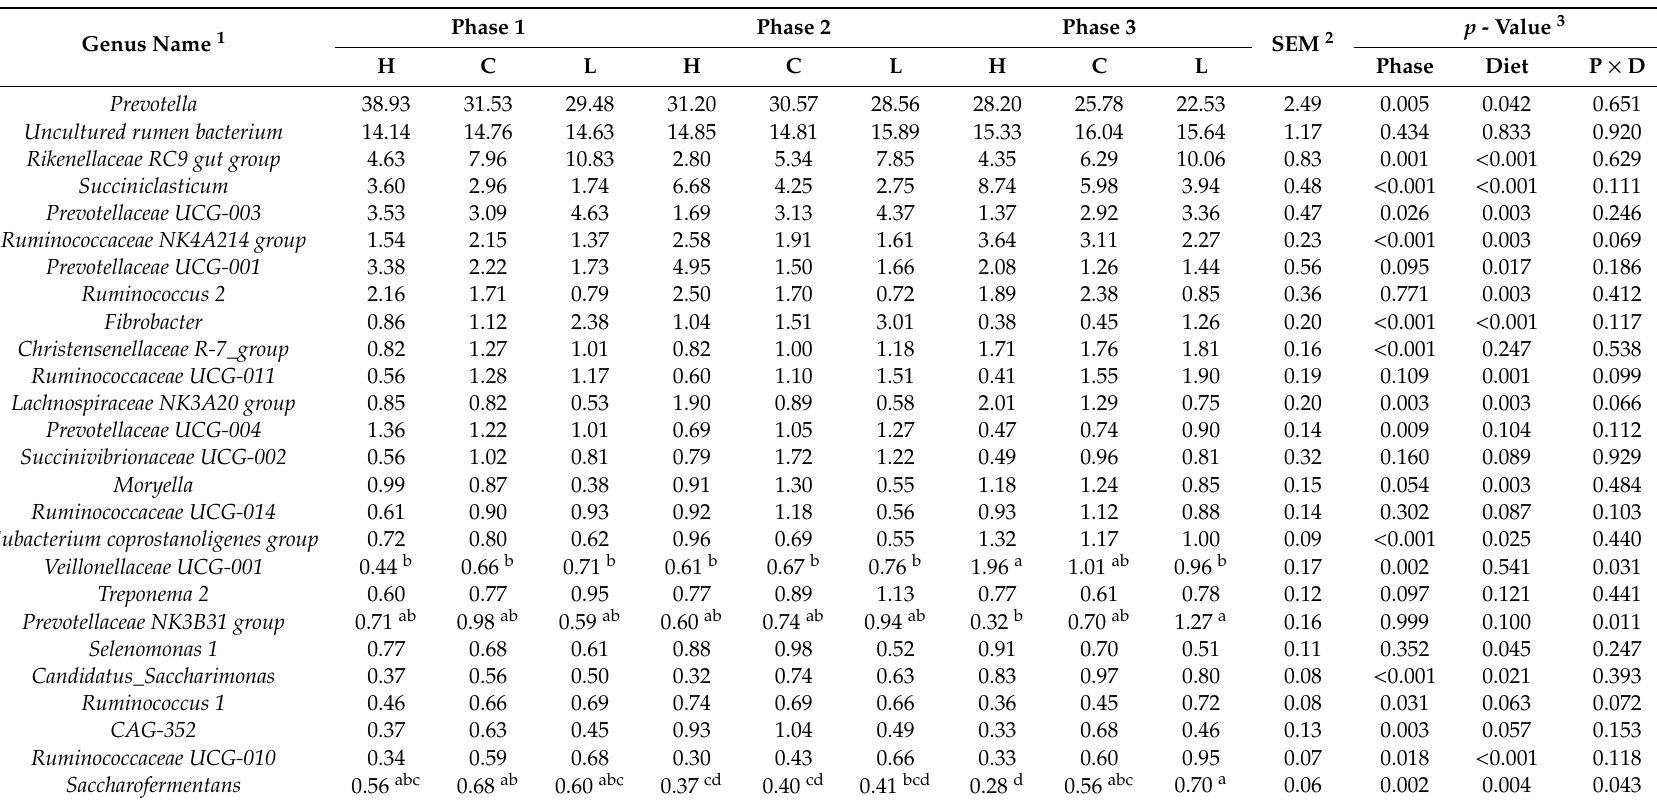
Table 7. E ff ects of dietary nutrient density on rumen bacterial composition at genus level (relative abundance > 0.5%) in the whole fattening phases of Holstein